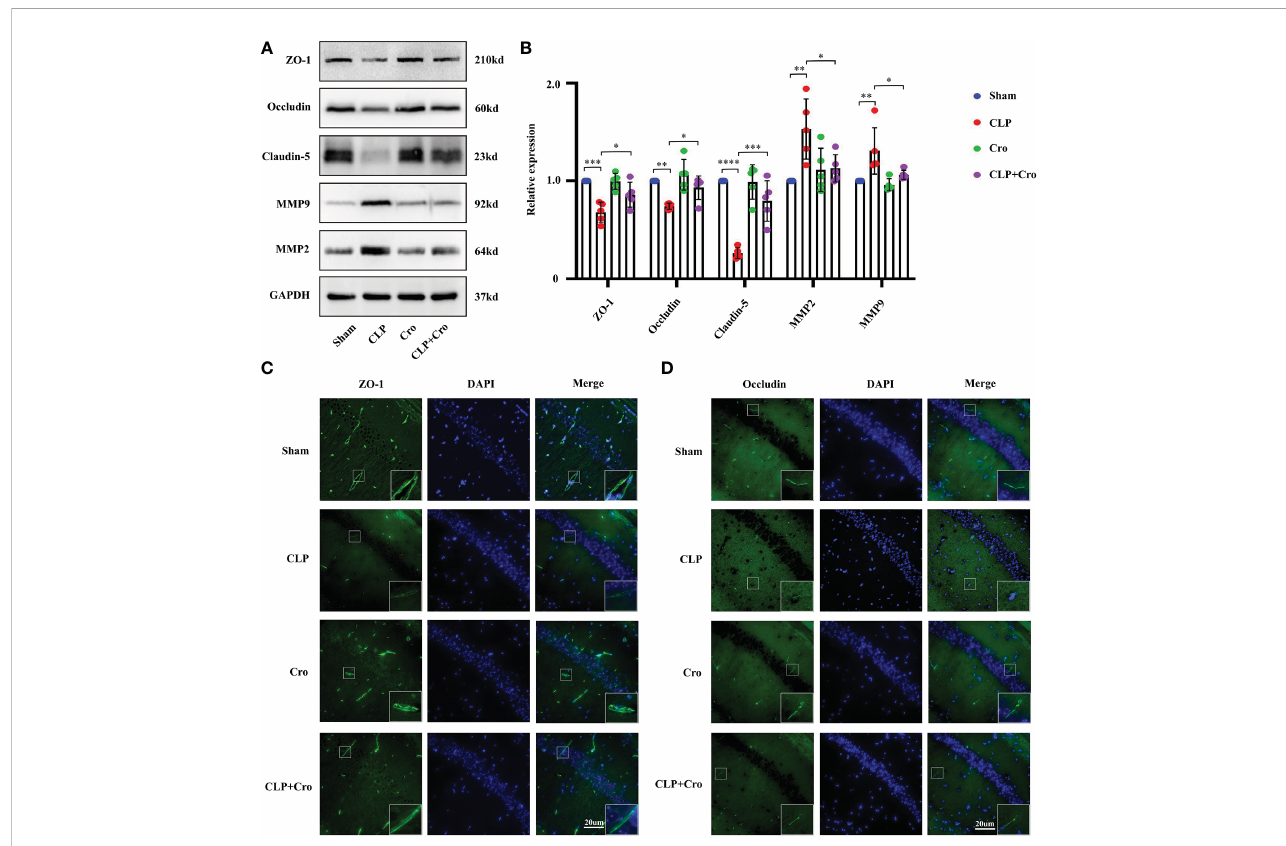
FIGURE 4 The inhibition of MC activation by cromolyn protected BBB integrity in septic mice by alleviating TJ disruption. (A) Expression levels of MMP2/9 and TJ (ZO-1, occludin and claudin-5) proteins in the hippocampus were detected by Western blot (n=5). (B) Expression levels of MMP and TJ proteins were quanti fi ed and normalized to GAPDH levels (n=5). Expression levels of ZO-1 (C) and occludin (D) in the CA1 region of the hippocampus were analyzed by IF assay (400x, n=6). MCs, Mast cells; CLP, Cecal Ligation and Puncture; SAE, Sepsis-associated encephalopathy; BBB, Blood – brain barrier; TJs, Tight junctions; IF, immuno fl uorescence. (* p <0.05, ** p <0.01, *** p <0.001, **** p